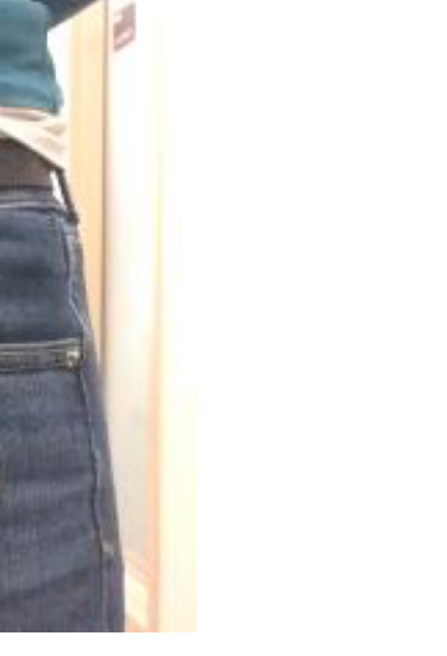
Fig 1. WREN worn by student.